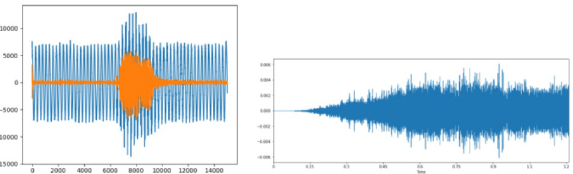
Figure 1: Data is shown by plotting it using Scipy(left) and